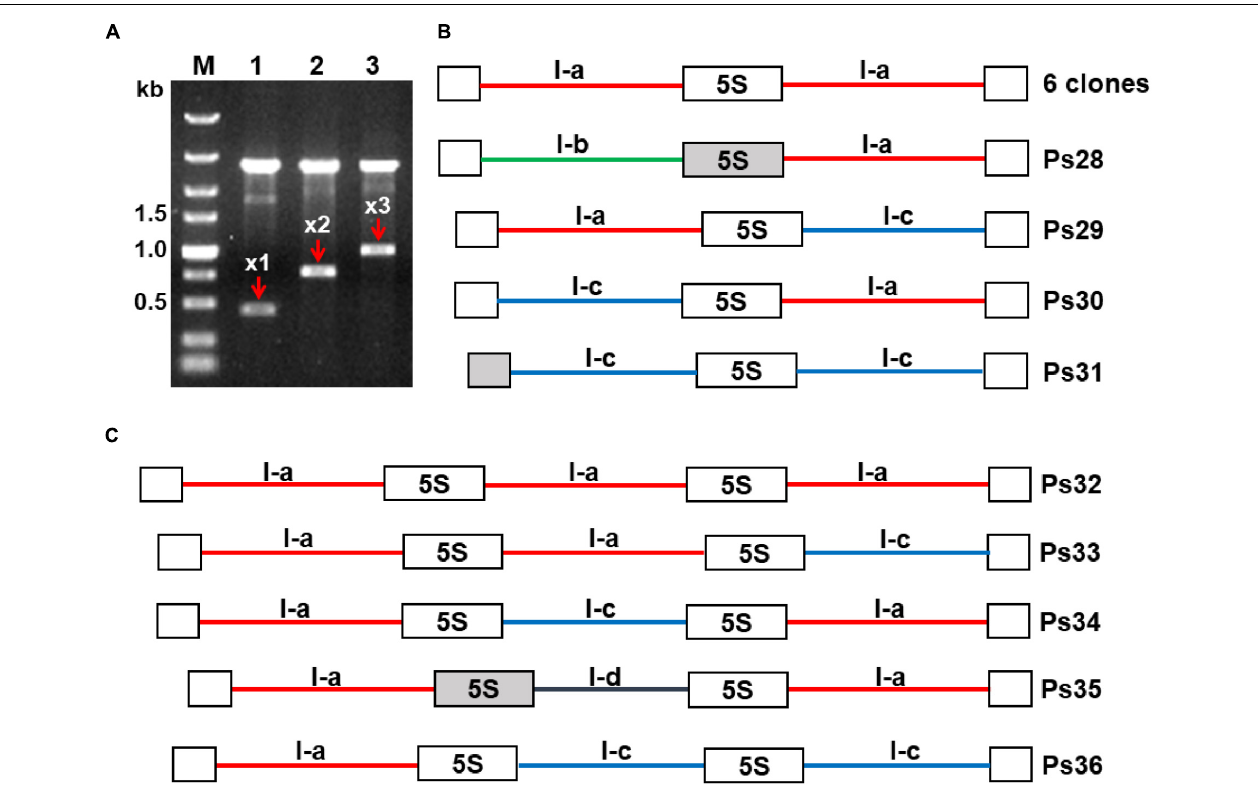
FIGURE 6 | Modes of repeat arrangement revealed in clones containing multiple 5S rDNA units. (A) Agarose gel showing digested plasmids containing DNA fragments composed of one (x1), two (x2), and three (x3) units of 5S rDNA in the representative clones Ps20, Ps25, and Ps35, respectively. (B) Schematic representation of the arrangement of rDNA units with NTS types I-a, I-b, and I-c in clones containing two 5S rDNA repeats. (C) Schematic representation of the arrangement of rDNA units with NTS types I-a, I-c, and I-d in clones containing three 5S rDNA repeats. All depicted DNA clones are in 5 (cid:48) –3 (cid:48) orientation. Open boxes represent full-length (119 bp) 5S rDNA genes; gray boxes in clones Ps28, Ps31, and Ps35 represent 5S rDNA pseudogenes. The six identical clones with double NTSs of type I-a are represented in GenBank by the sequence Ps22 with accession number OL409056. The accession numbers of other sequences are as follows: Ps28—OL409060; Ps29—OL409057; Ps30—OL409058; Ps31—OL409059; Ps32—OL409061; Ps33—OL409062; Ps34—OL409063; Ps35—OL409064;